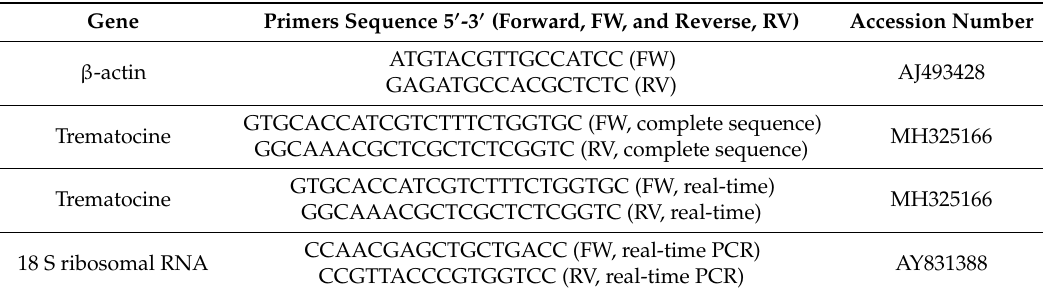
Table 4. Primers used for cloning and expression